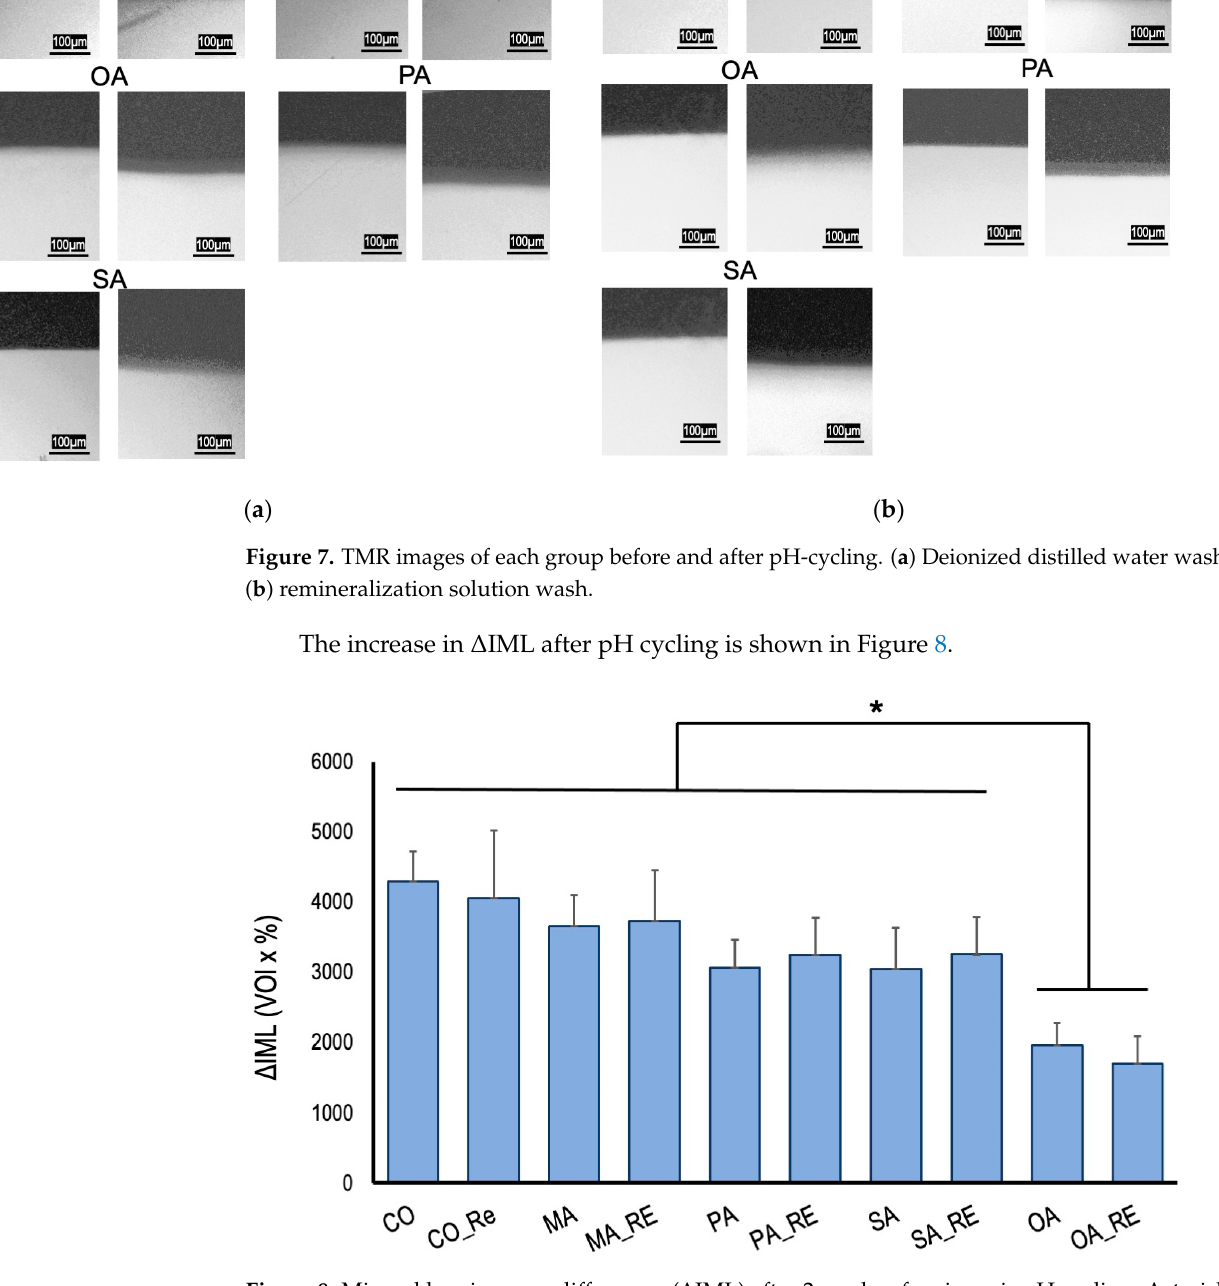
Figure 8. Mineral loss increase differences ( ∆ IML) after 2 weeks of cariogenic pH cycling. Asterisk significant differences (one-way ANOVA and Tukey’s tests, p <